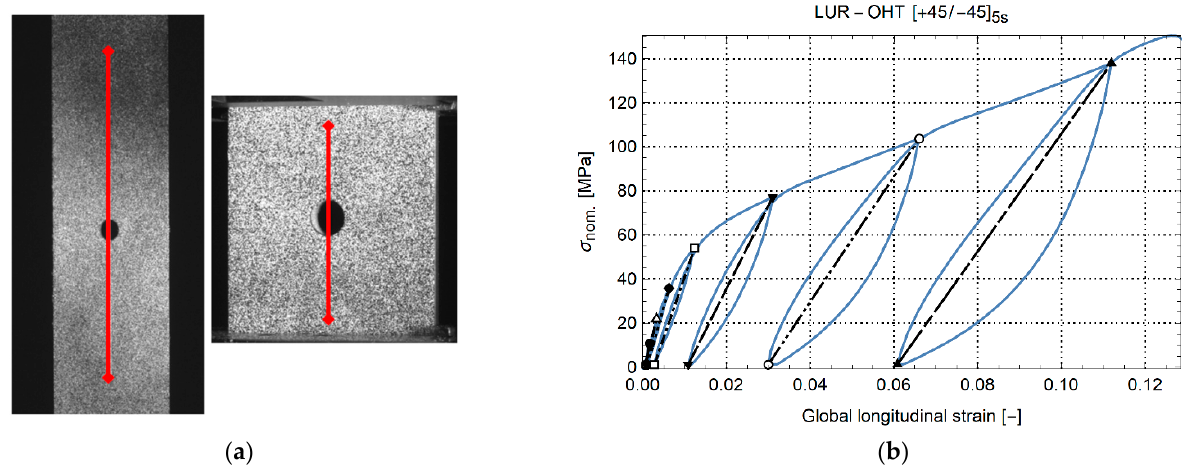
Figure 2. ( a ) Global sample strain gauge for tension (left) and compression (right) specimen, ( b ) nominal stress–global strain of an open-hole sample with layup [+45/ − 45] 5s under tension load.